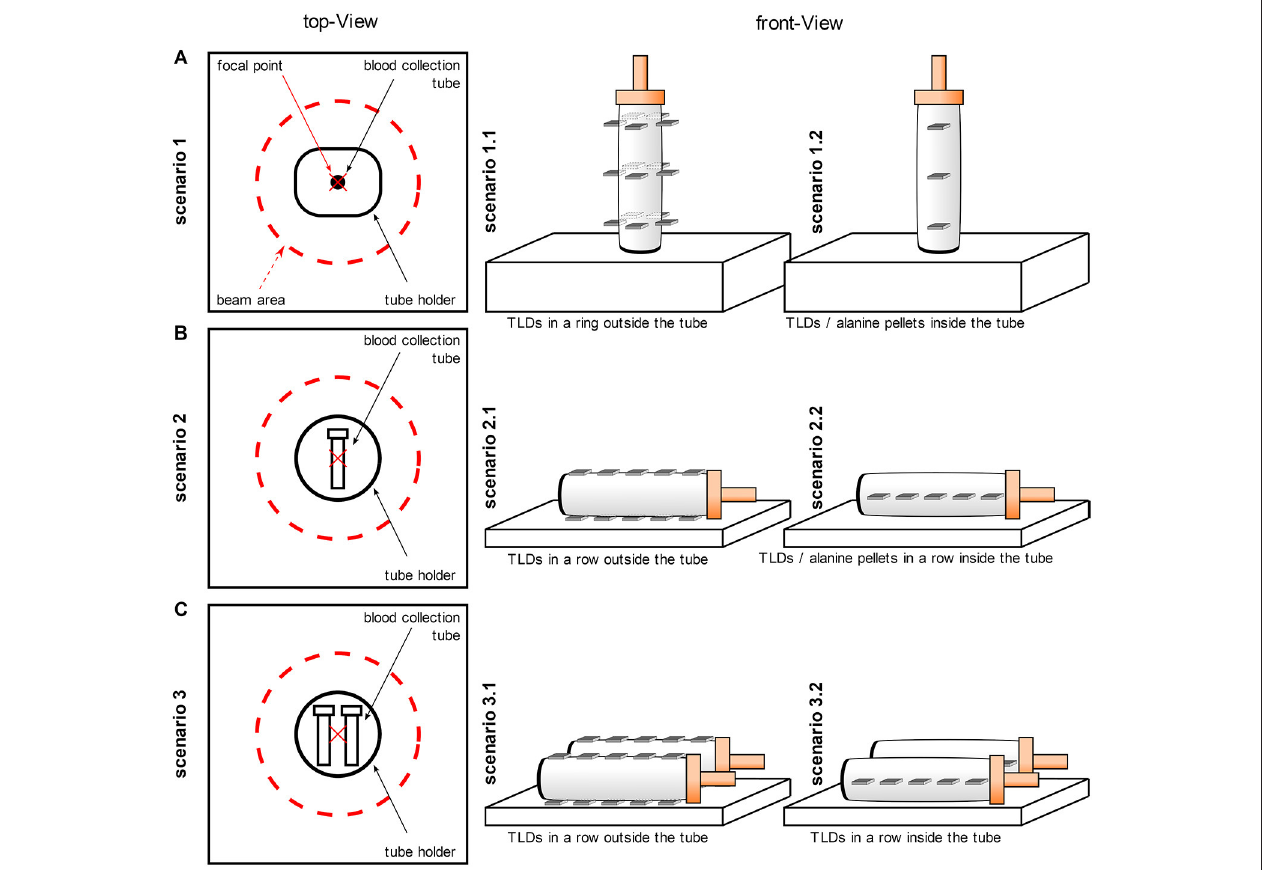
FIGURE 1 | Schematic representation of the experimental setup. The irradiations were performed in three different scenarios. For all scenarios, the blood collection tubes were filled with water for physical dose measurements or with whole blood for biological dosimetry studies. (A) One blood collection tube was positioned vertically in the central position of the radiation field (scenario 1) and TLDs were placed in three rings on the outer surface of the tube (scenario 1.1) or TLDs or alanine pellets were placed in a row inside the tube (scenario 1.2). (B) One blood collection tube was placed horizontally in the center of the radiation field (scenario 2) and TLDs were placed in two rows above and below on the outer surface of the tube (scenario 2.1) or TLDs or alanine pellets were placed in one row inside the tube (scenario 2.2). (C) Two blood collection tubes were irradiated horizontally at the same distance from the central position of the radiation field (scenario 3) and the TLDs were placed in two rows above and below on the outer surface of the tube (scenario 3.1) or the TLDs were placed in one row inside the tube (scenario 3.2).